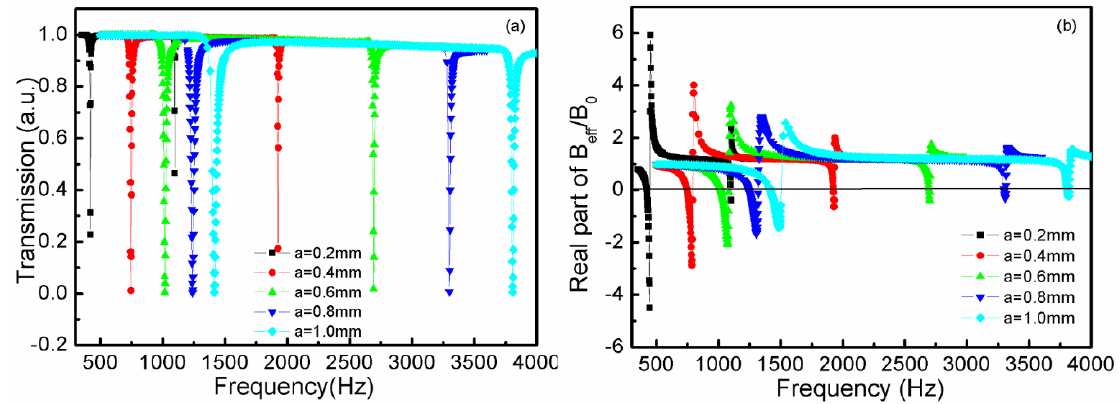
Figure 4. The curves of the TLSHSs with various hole diameters: ( a ) transmission and ( b ) effective modulus.